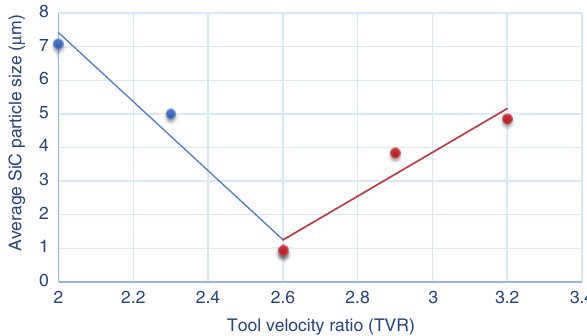
Figure 8: Effect of TVR on average SiCp size.